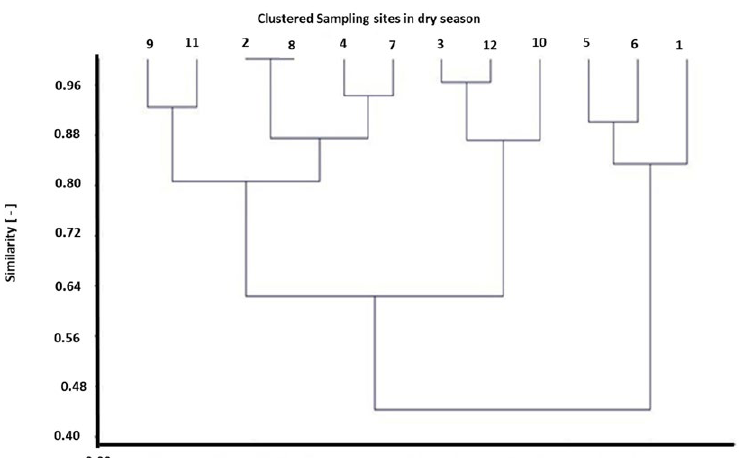
Fig 4: Cluster Dendrogram of 12 sampling sites, based on the average linkage cluster analysis of macroinvertebrates in the dry season